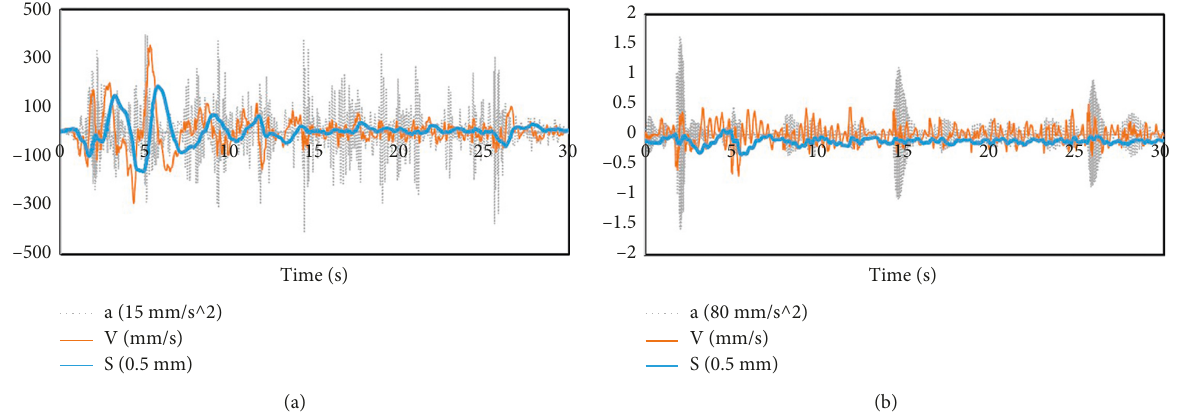
Figure 50: Time course curves of bearing deformation displacement, velocity and acceleration when ELC is input from Y direction. (a) Horizontal deformation. (b) Vertical